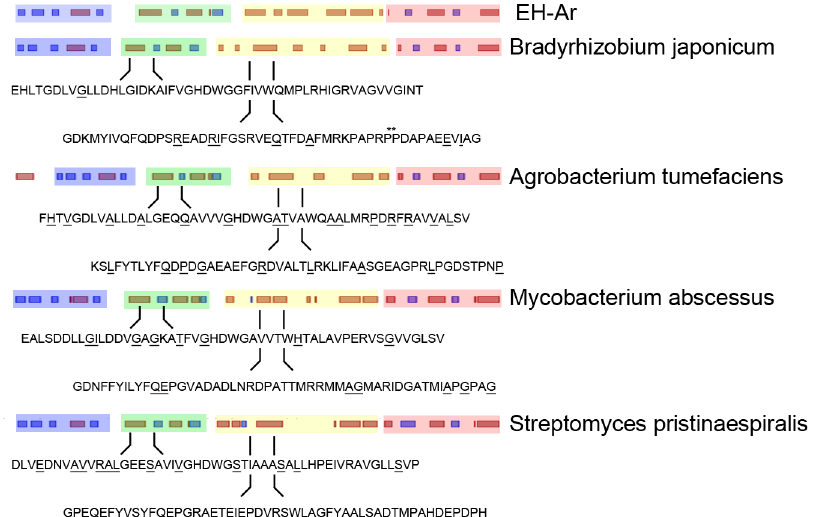
Fig 4. Overview of EHs from different species. Secondary structure alignment ( β -sheets — blue bars, α - helices — dark red bars, uncolored empty space — linking structural elements) of EHs from different organisms [54]. The domains are color coded according to EH-Ar crystal structure (PDB 1EHY, Fig 1A). Downstream of the domain boundaries (20 – 70 aa), according to the identified slow-translating regions of EH-Ar (translation profile, Fig 1A), the amino acid sequences of each EH is shown and the amino acids encoded by rare codons are underlined. Rare codons are defined as the ten least used codons for each